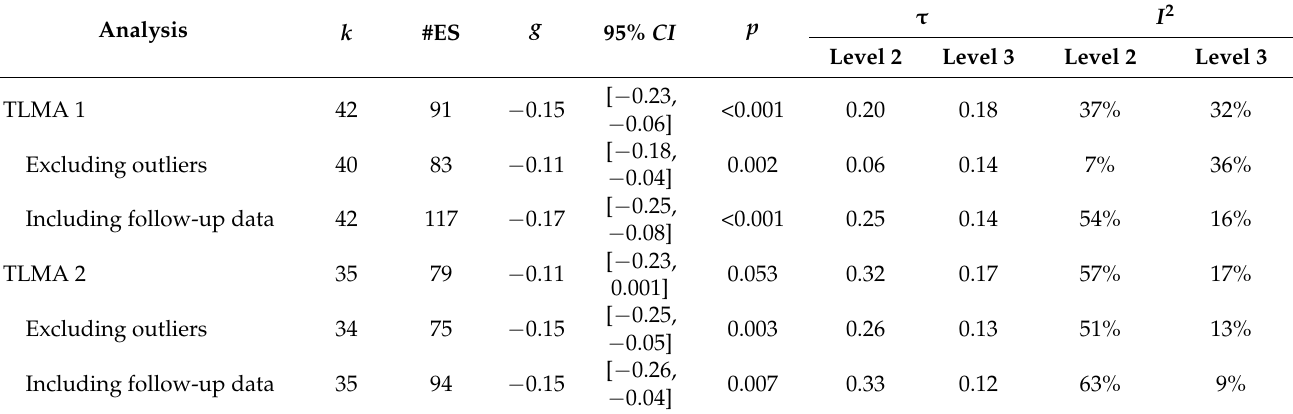
Table 3. Pooled Effect Size Estimates and Effect Size